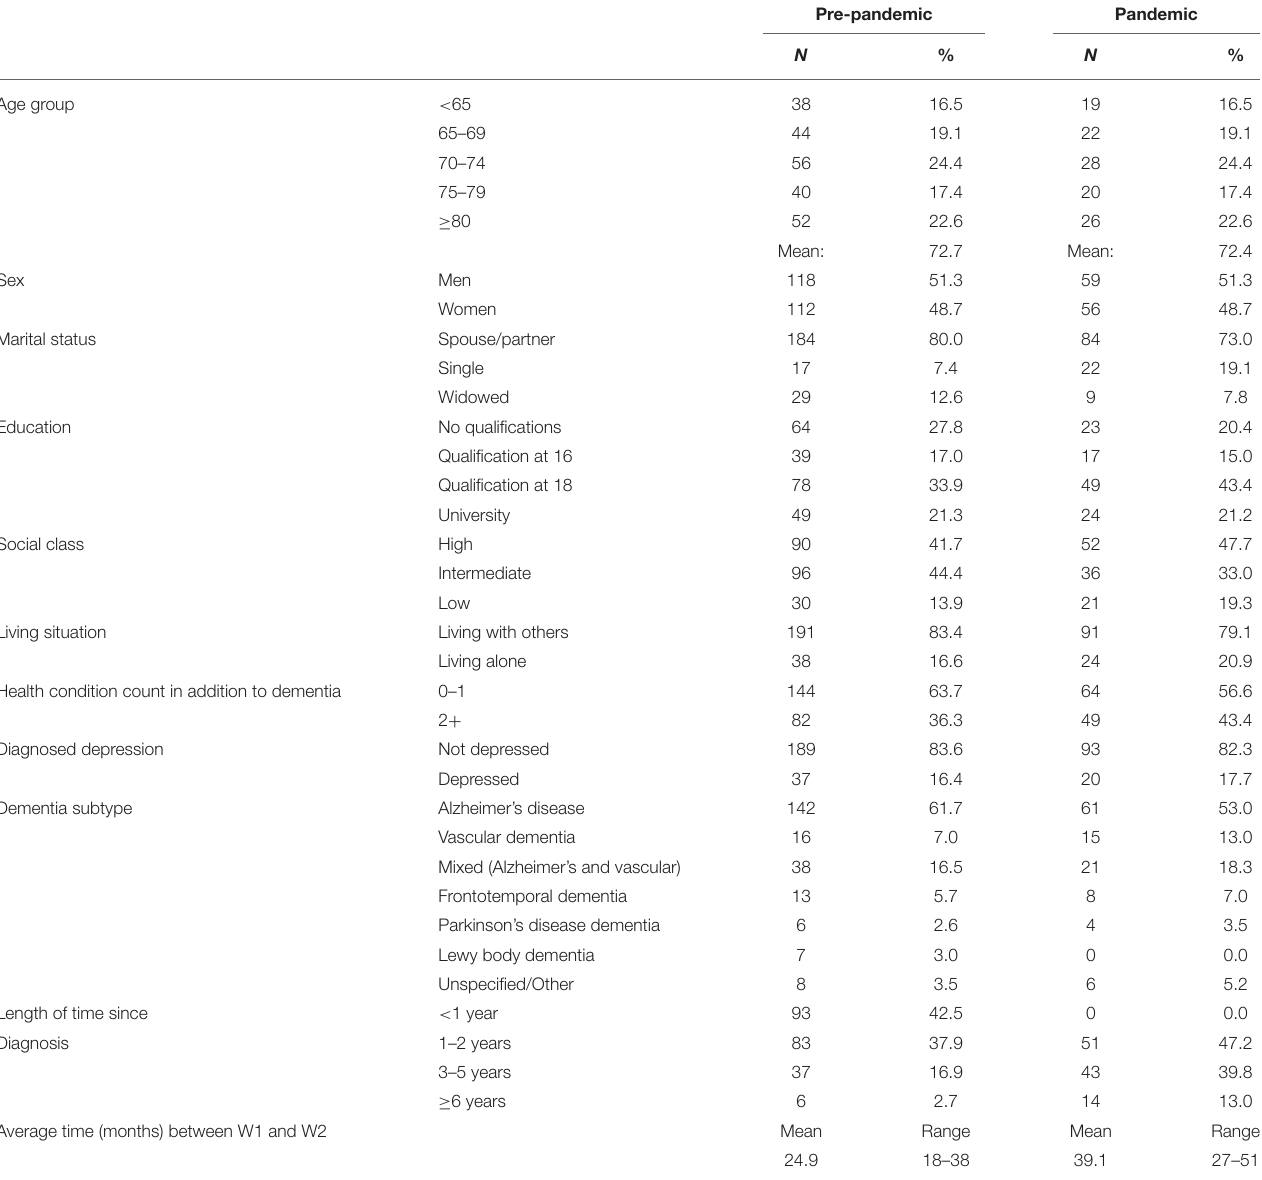
TABLE 1 | Demographic profiles of the pre-pandemic and pandemic groups.